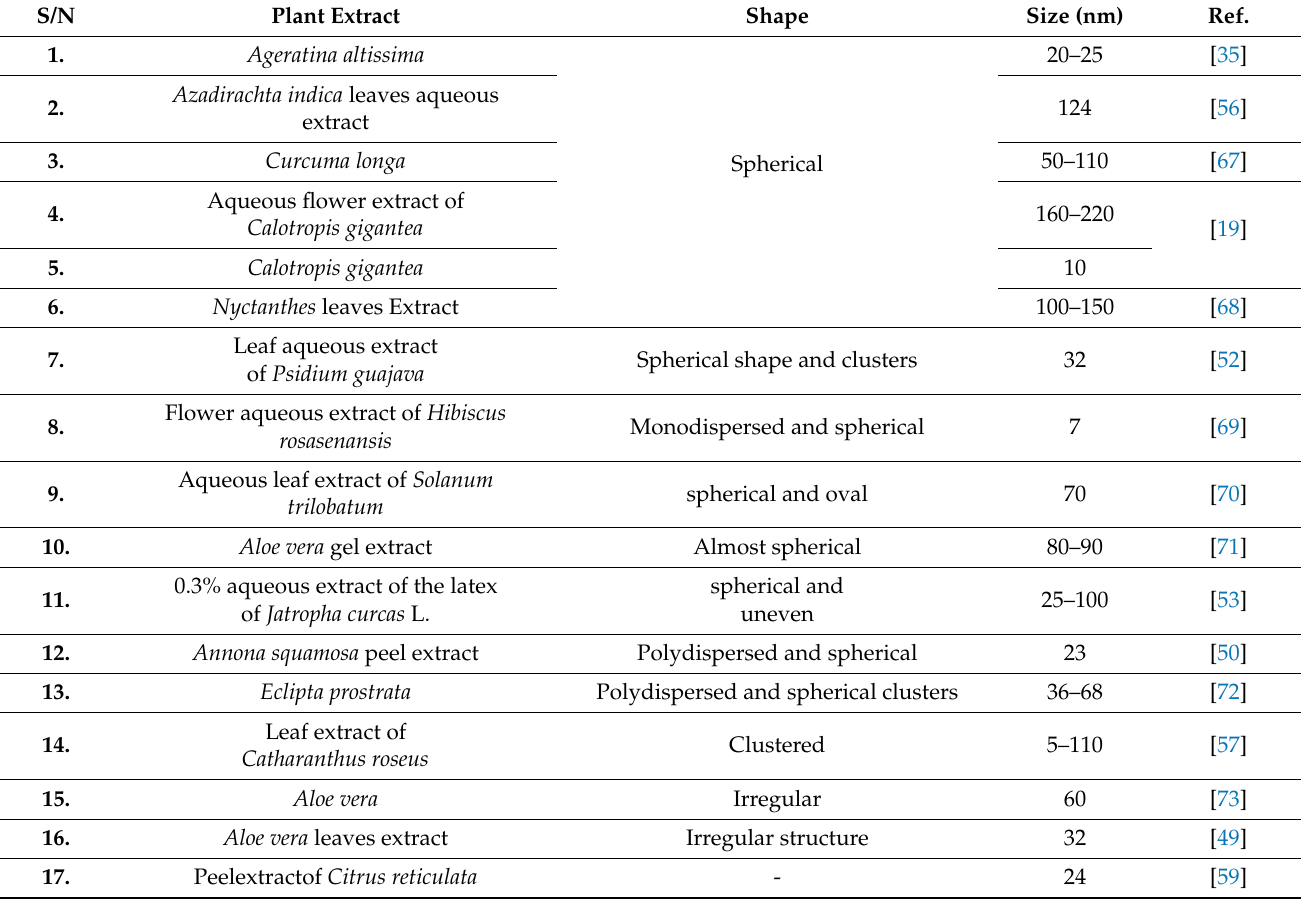
Table 1. TiO 2 NPs prepared by utilizing a variety of